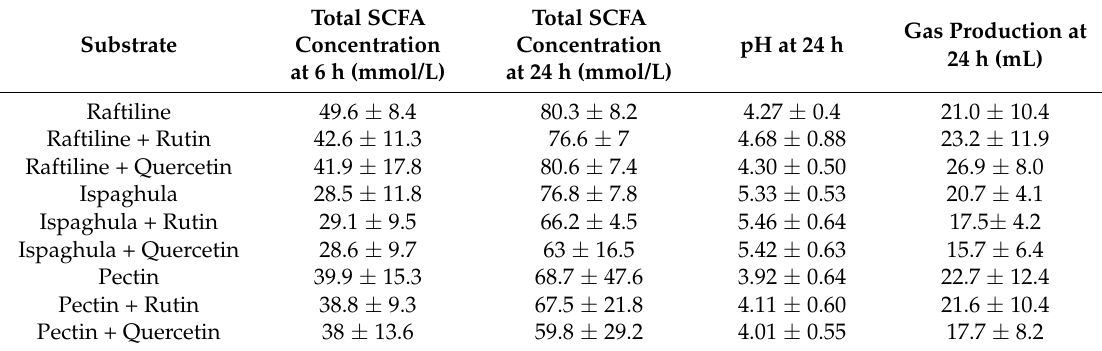
Table 3. Total short-chain fatty acid (SCFA) production (6 and 24 h post-fermentation), gas, and pH measurement (at 24